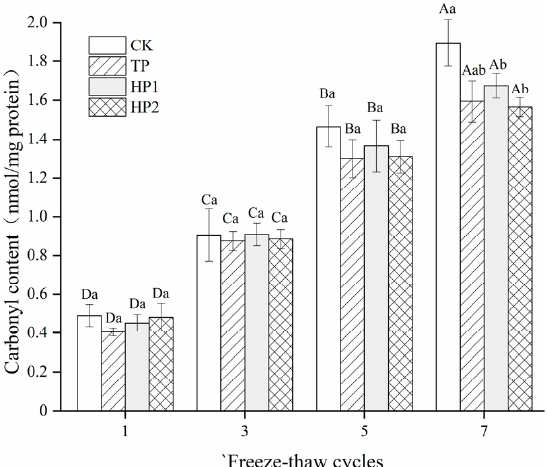
Figure 4. Changes in carbonyls’ contents in freeze-thawed fish fillets: CK: fillets in distilled water; TP: fillets in tea polyphenol; HP1: fillets in 1% bone hydrolysates; HP2: fillets in 2% bone hydrolysates. Different capital letters indicate the results that differ significantly in freeze–thaw cycles with the same treatment ( p < 0.05). Different lowercase letters indicate the results that differ significantly with different treatments in the same freeze–thaw cycle ( p < 0.05).